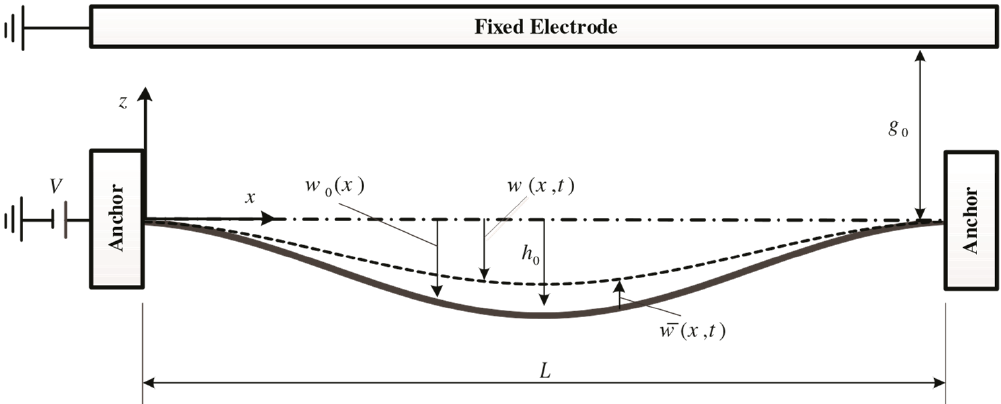
Figure 1. The schematic diagram of the arch MEMS resonator.